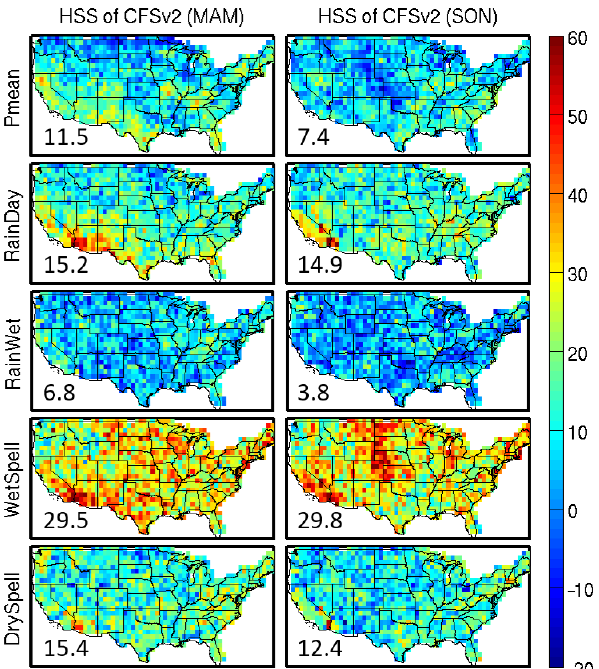
Figure 4. Same as in Fig. 3, but for MAM and SON. Figure 5. Spatially normalized standard deviations of observed 30- day precipitation indices in January and July over the 28-year period from 1982 to